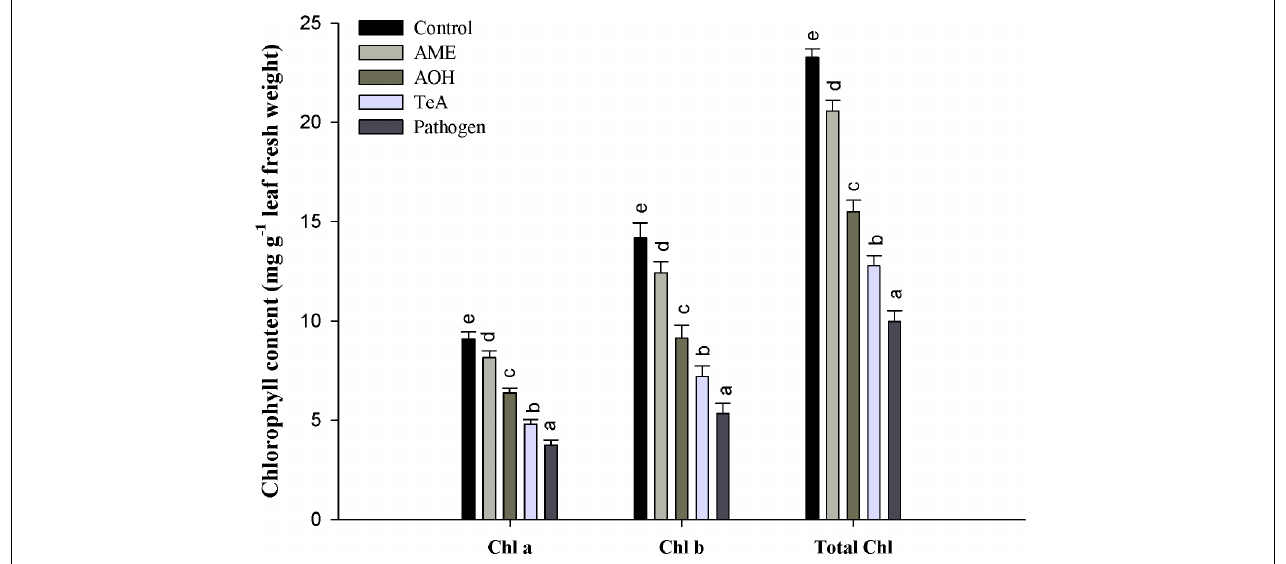
FIGURE 4 | Effect on chlorophyll content in tomato plants treated with pathogen and their metabolites after 48 h. The results are expressed as the mean of three replicates and vertical bars indicate the ± SD of the mean.